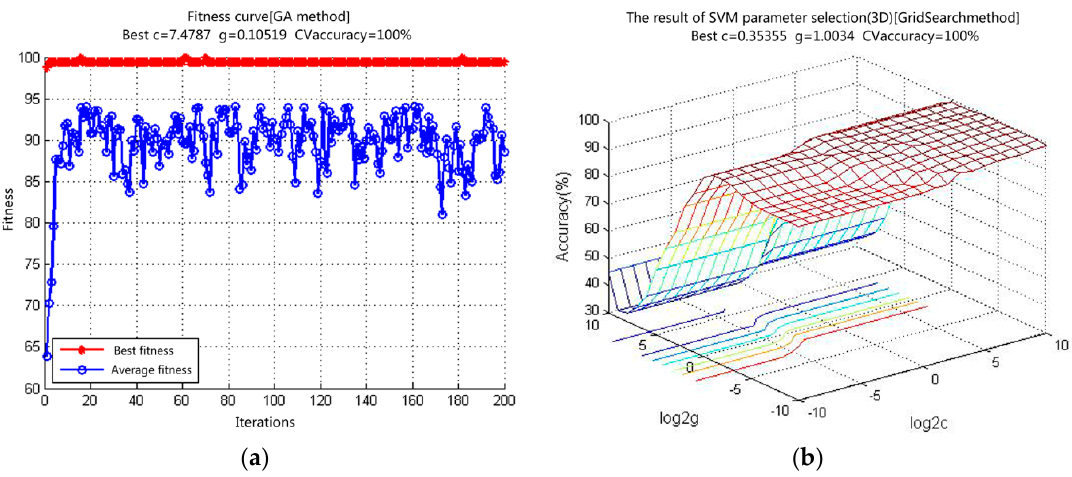
Figure 7. ( a ) Fitness curve of GA; and ( b ) selection results of the Grid Search optimization parameters of the 3-D chart. Table 2. Classification results of Grid Search-SVM (support vector machine).